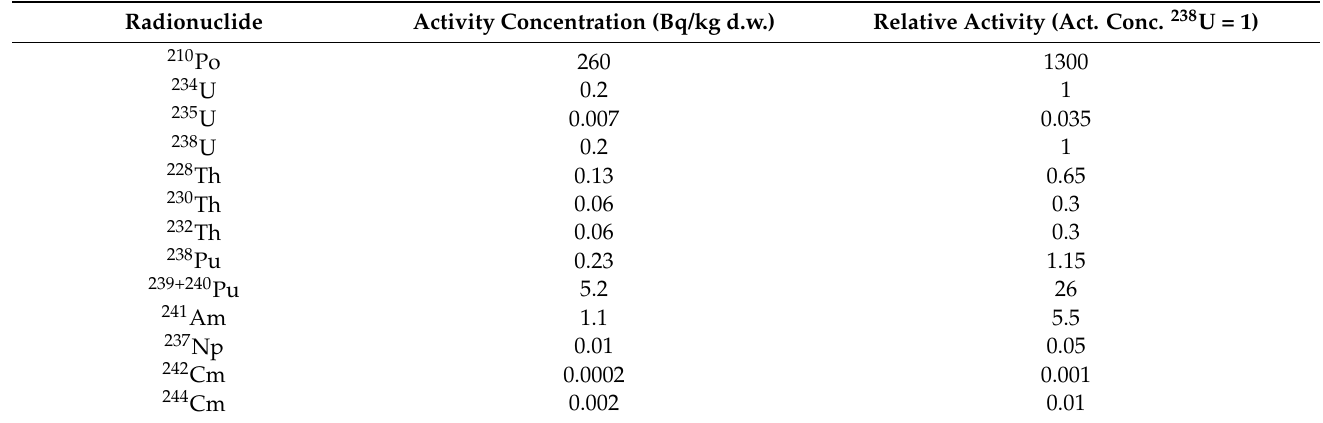
Table 3. Alpha-emitting radionuclides in lichen in Sweden in 1972 (original data from Holm and Persson [27]) and relative activities compared to 238 U. Radionuclide Activity Concentration (Bq/kg d.w.) Relative Activity (Act. Conc. 238 U = 1) 210